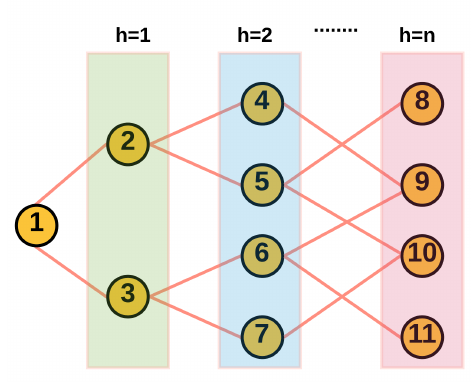
Figure 3. Example of Hope Distance Between Nodes